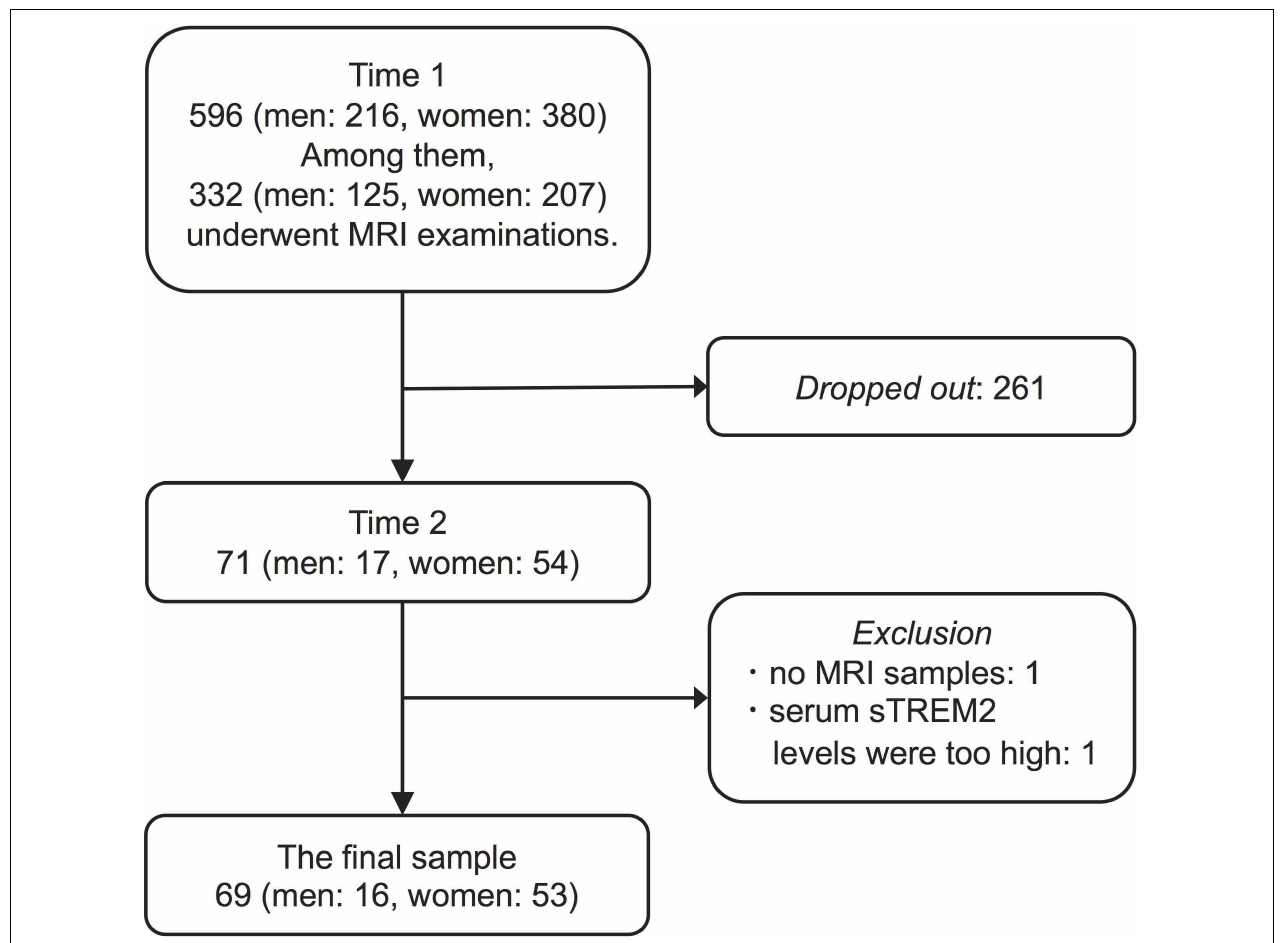
FIGURE 1 | Flow chart depicting selection